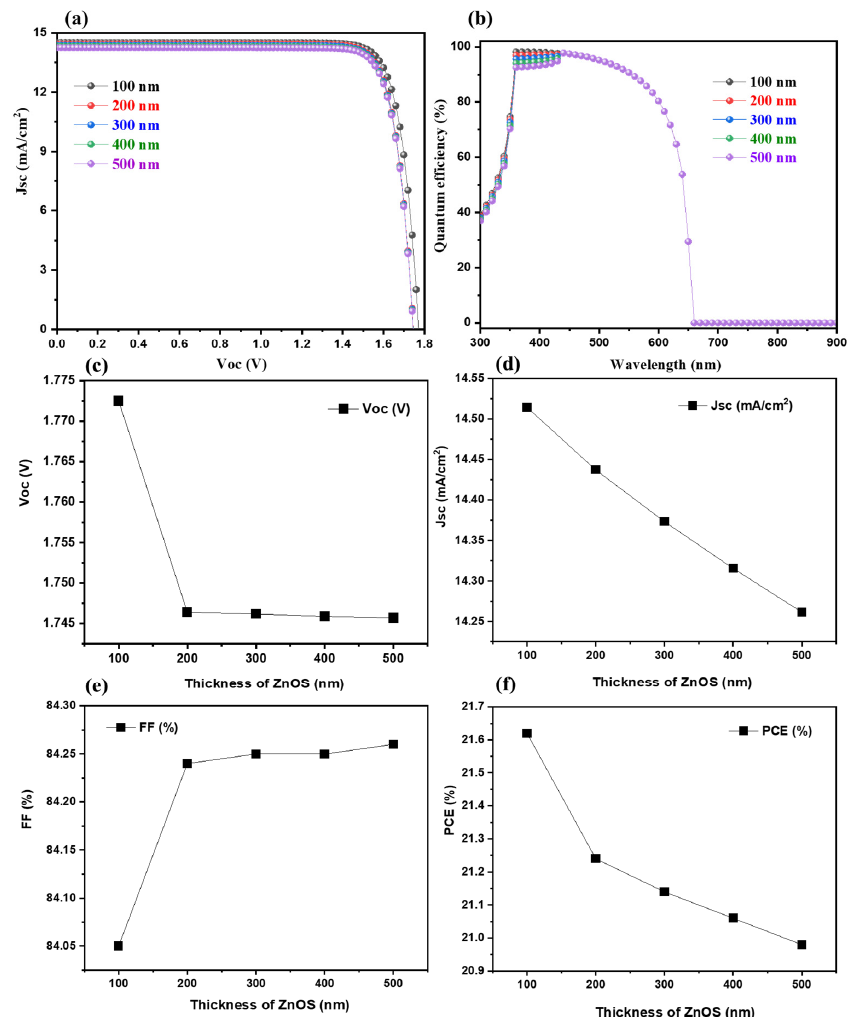
Figure 6. J-V curves ( a ) and EQE curves ( b ) of the simulated PSCs (FTO(500 nm)/ZnOS(100–500 nm)/ MAGeI 3 (550 nm)/spiro-OMeTAD(100 nm)) at 300 K. Extracted Voc ( c ), Jsc ( d ), FF ( e ) and PCE ( f ) of the simulated PSCs (FTO(500 nm)/ZnOS(100–500 nm)/MAGeI 3 (550 nm)/spiro-OMeTAD(100 nm)) at 300